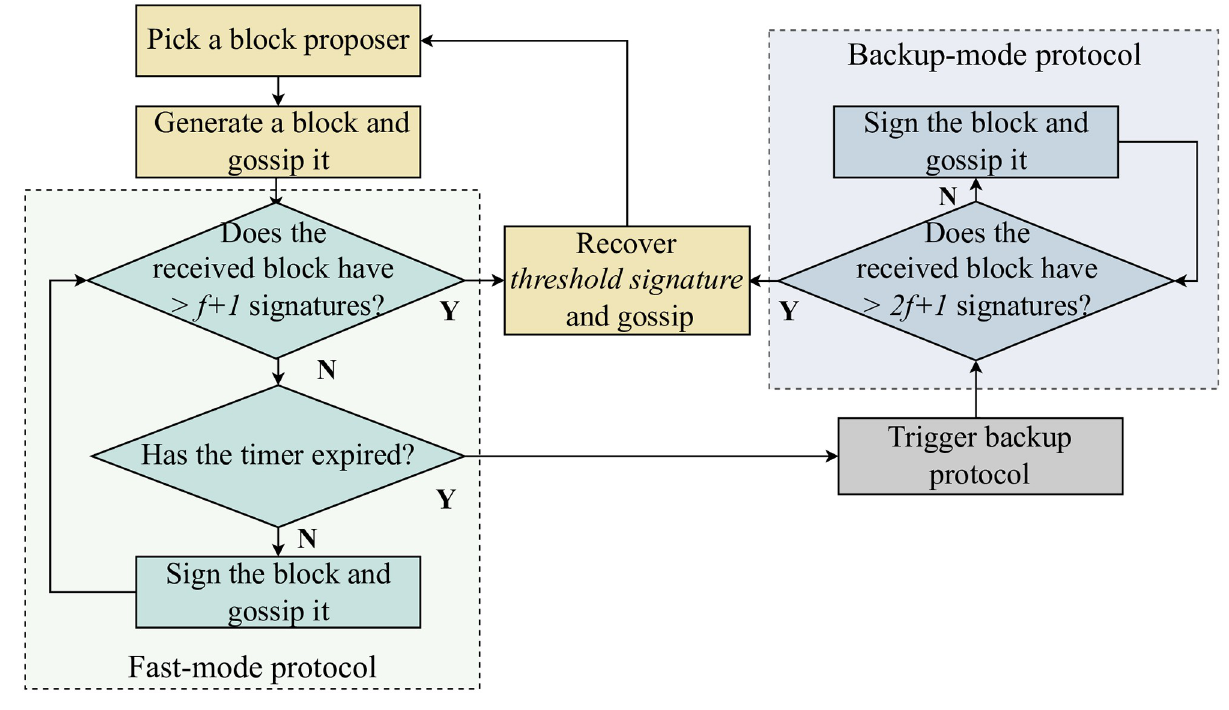
Fig 3. Overall operation of Flexico dual-mode